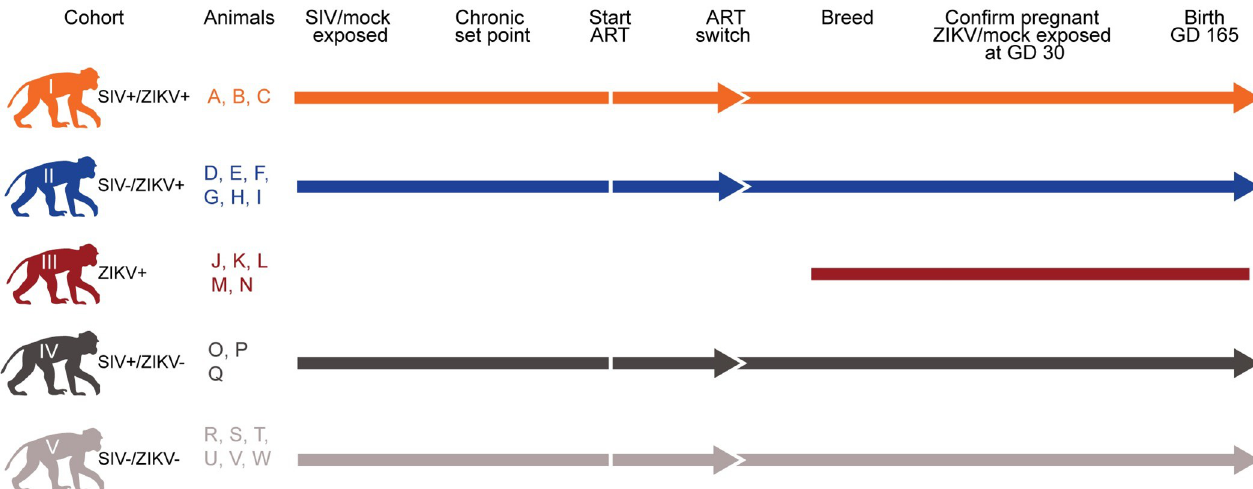
Fig 1. Study Design and cohort definitions. The 23 pregnancies in this study are grouped into Cohorts I-V according to the dam’s viral exposure(s) and antiretroviral therapy (ART) regimens. Once the chronic set point was reached following intrarectal (IR) SIV exposure, the animals began the first ART regimen of tenofovir disoproxil fumarate (TDF), emtricitabine (FTC), and dolutegravir sodium (DTG). Thirty days before breeding, animals were switched to a new ART regimen of TDF/FTC/Raltegravir (RAL). Arrowheads denote a switch in ART regimen. Animals were bred until pregnancy was confirmed by ultrasound. On or around gestational day (GD) 30, animals were exposed subcutaneously (SC) to either ZIKV or PBS (mock). Maternal fetal-interface (MFI) and fetal/embryonic tissues were collected on the date of pregnancy loss or birth (~GD 165). Animals that did not deliver naturally by GD 170 had Cesarean sections (C-sections). Macaque silhouettes were prepared by L. Raasch and are not restricted by copyright.